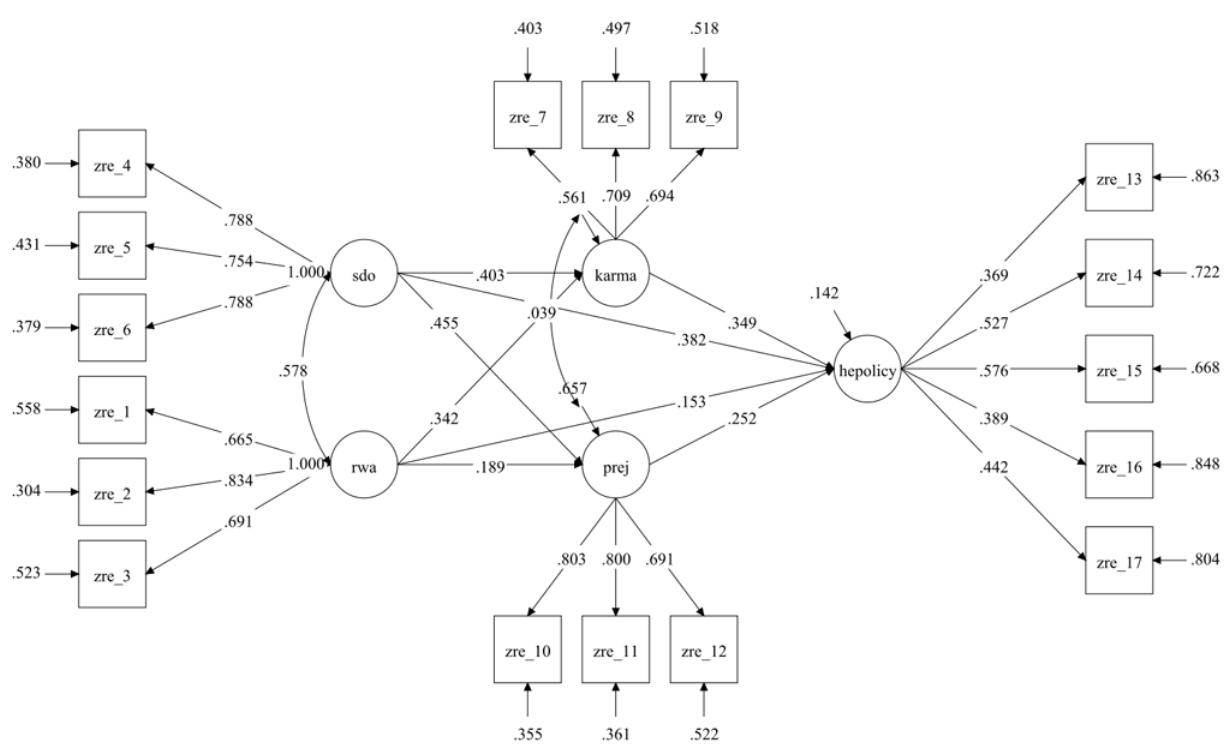
Figure 1. Generalized Hierarchy-Enhancing (HE) Policy Support as a Function of Latent Social Dominance Orientation (SDO), Right-Wing Authoritarianism (RWA), Karmic Beliefs, and Generalized Prejudice (see